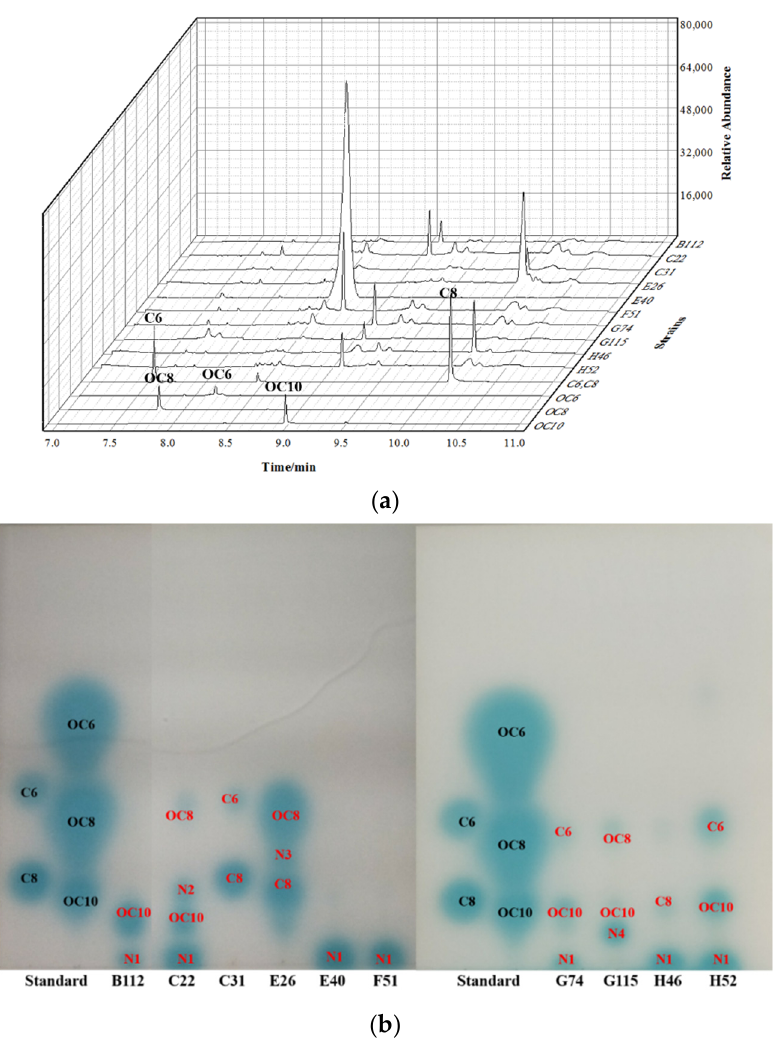
Figure 2. AHLs produced by microalgae-associated QS bacteria via GC-MS ( a ) and TLC ( b ) analysis. ( a ) Ethyl-acetate extracted 10 QS bacteria’ supernatant analysed by GC-MS. The standards included five AHLs: C6 (retention time: 7.54 min), C8 (retention time: 10.17 min), OC6 (retention time: 8.21 min), OC8 (retention time: 7.83 min), OC10 (retention time: 8.96 min). ( b ) Detection of